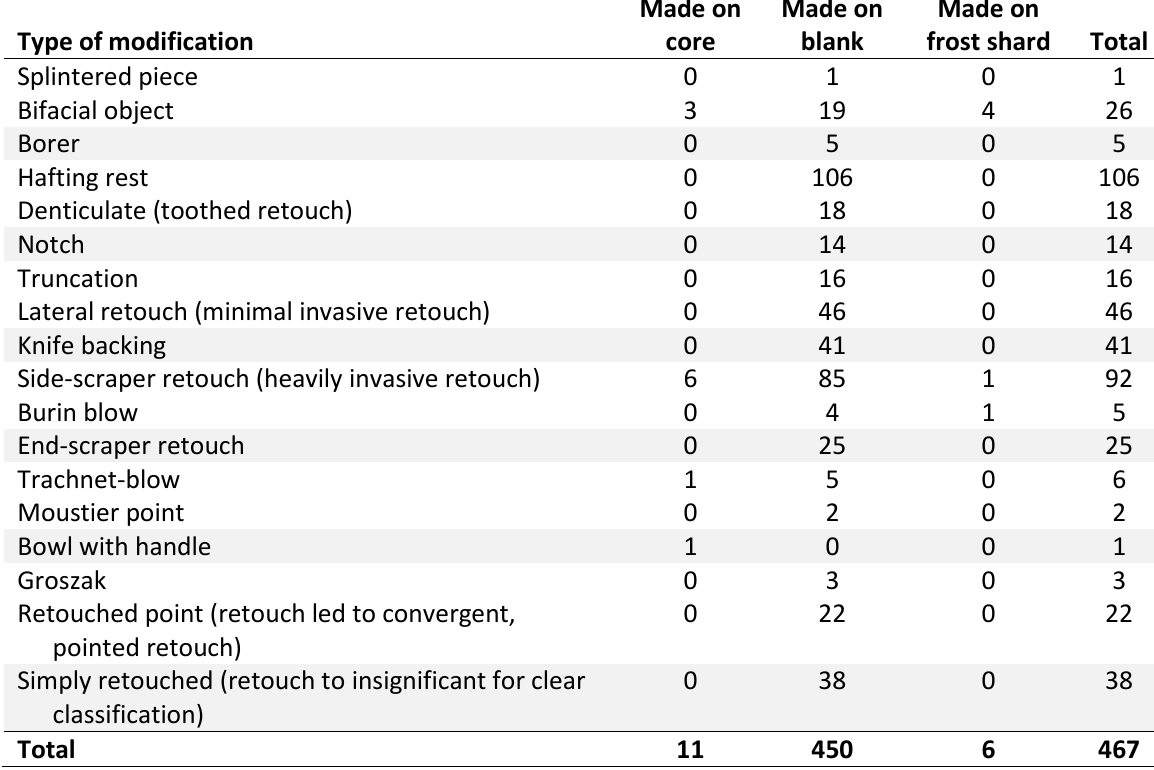
Table 11. Numbers of modification types on lithic objects from GH